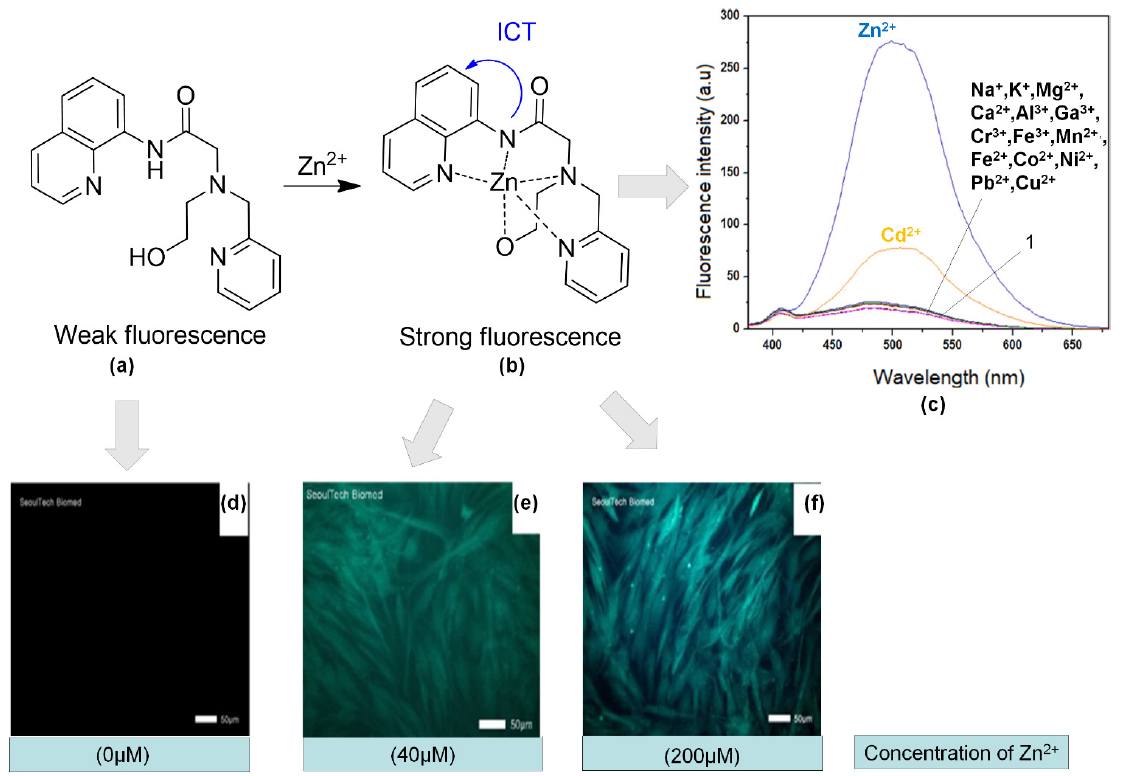
Figure 12. ( a ) Structure of 1. ( b ) Fluorescence enhancement mechanism and proposed structure of 1 upon binding with Zn 2+ . ( c ) Fluorescence spectra of 1 in the presence of different cations in 10 mM bis–tris, pH 7.0 buffer ( λ exc = 356 nm). Fluorescence images of fibroblasts cell that exposed to Zn 2+ at different concentrations 0 ( d ), 40 ( e ), and 200 ( f ) μ M for 4 h and then cultured with 1 for 30 min. Sensors 2021 , 21 , x FOR PEER REVIEW